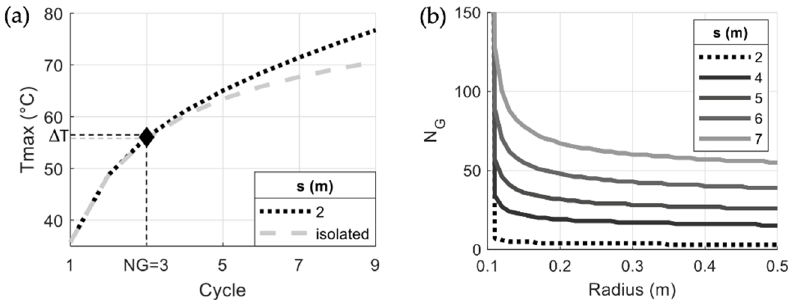
Figure 10. ( a ) Identification of cycles when group pile starts to affect the temperature ( N G ) at the outer surface of the pile section; ( b ) N G for each point of pile section.